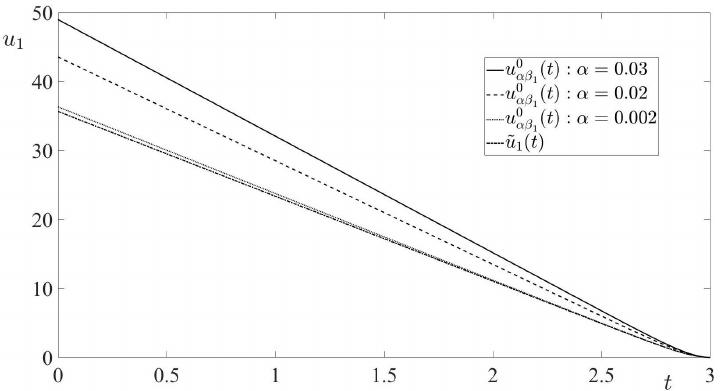
( t ) and limiting function ˜ u αβ 1